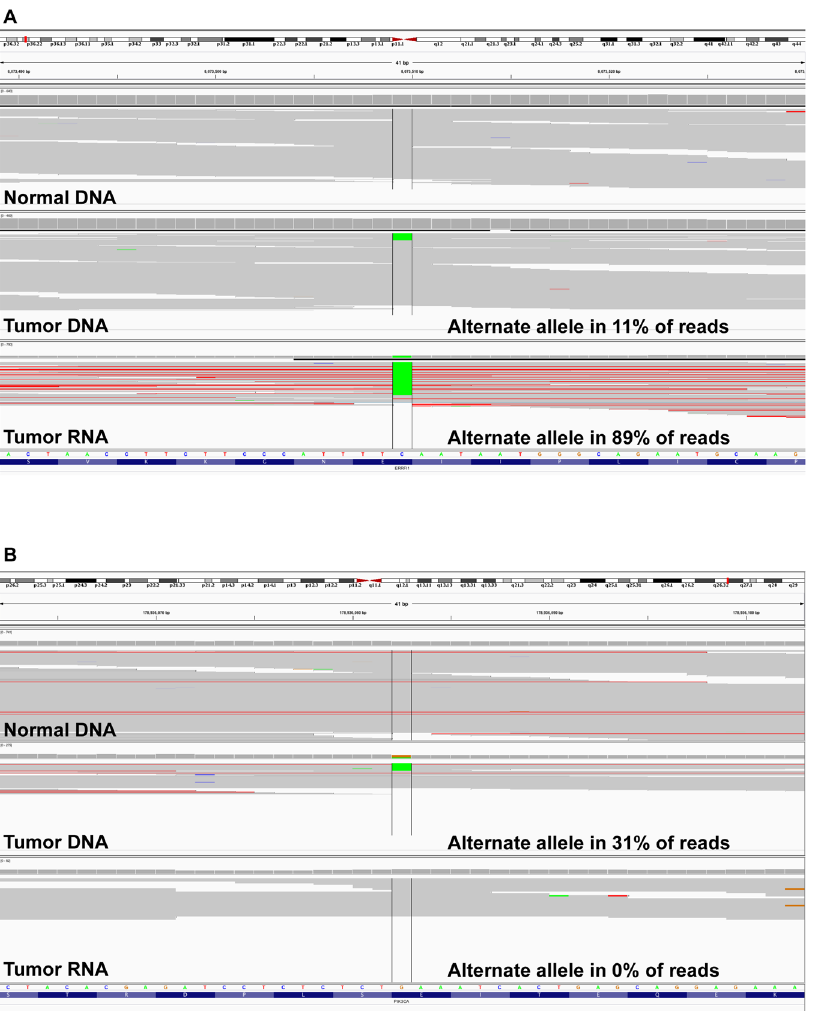
Figure 3. ( A ) Presence and ( B ) absence of alternate alleles in